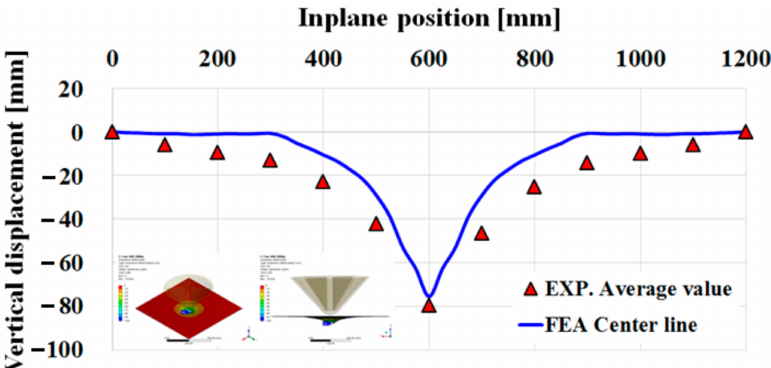
Figure 19. Vertical displacement comparison (drop height of 3